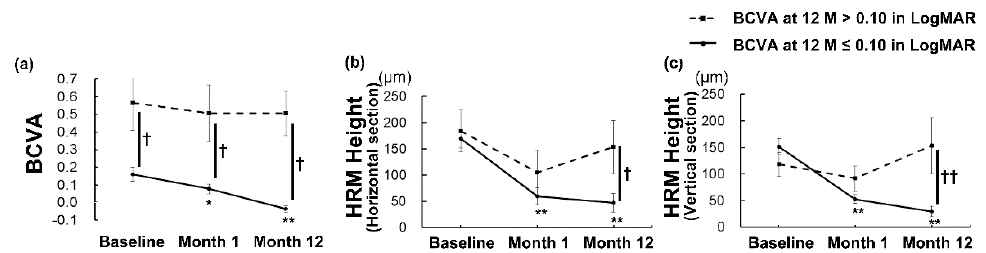
Figure 3. Changes in the best-corrected visual acuity (BCVA) and height of the hyperreflective material (HRM) over time in the eyes with or without a visual outcome better than 0.10 in LogMAR at month 12. ( a – c ) Mean ± standard errors are shown. Generalized analysis of variance was performed to compare the values at each time point and at baseline within each group (* p < 0.05, ** p < 0.01), and the Mann–Whitney U -test was used to compare the values between the groups ( † p < 0.05, †† p < 0.01). Mean BCVA ( a ) and mean HRM heights ( b , c ) improved as early as 1 month after initial treatment,